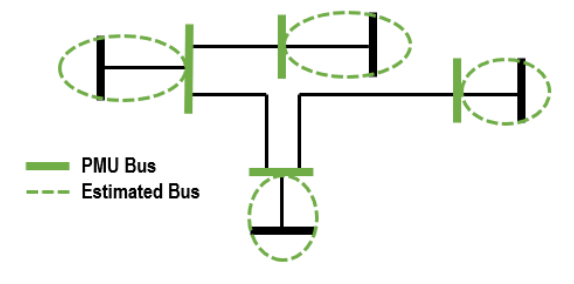
Figure 3. PMU-observable system with a reduced number of